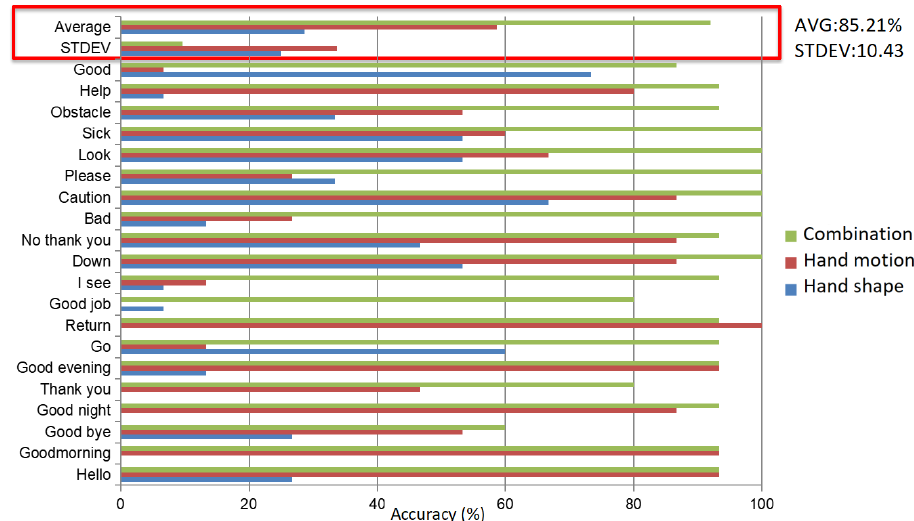
Figure 10. Comparison between the hand shape, hand motion, and combination methods. (The red boxes on the right give the values of AVG and STDEV for combination method.).